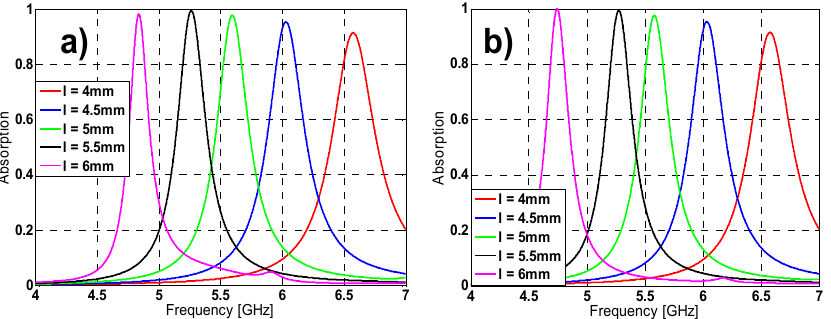
Figure 2. Results in simulation for different lengths of l for both ( a ) TE ( b ) TM.